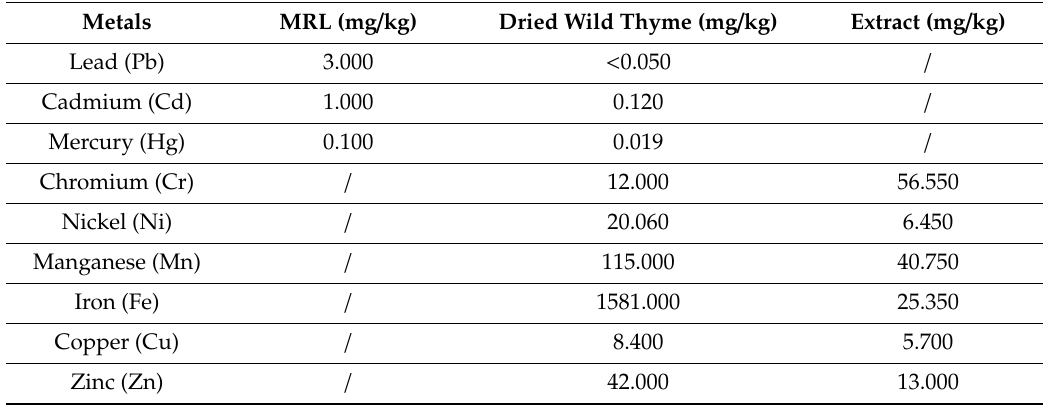
Table 8. Due to possible abrasion of electrodes during the treatment with HVED, content of metals was analyzed also in wild thyme extract obtained by HVED. For this purpose, extract TN8 was chosen that was treated with highest voltage (25 kV), nitrogen, for longer time (9 min) and highest ethanol content (50%), since highest abrasion is expected in such extract. Table 8. Residue levels and maximum residue levels (MRL) of metals (mg / kg) in dried wild thyme and in wild thyme